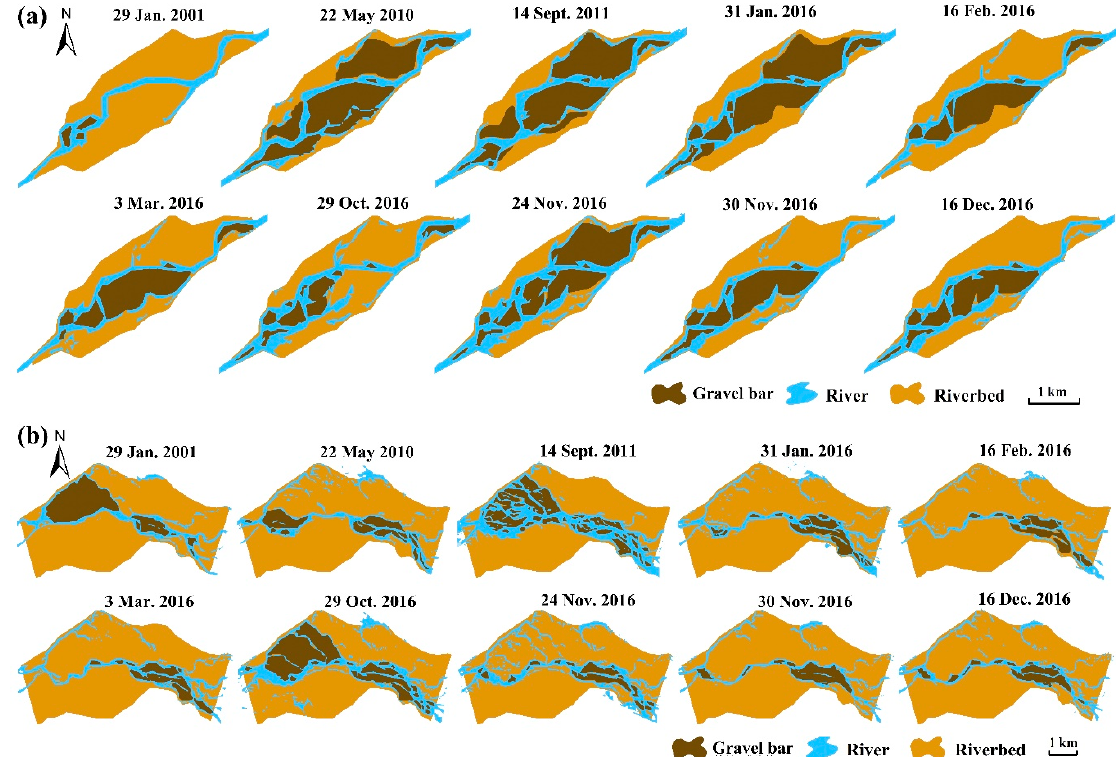
Figure 9. Morphological changes of local braided channel in RS1 and RS2 based on the remote sensing data. ( a ) RS1_B1; ( b ) RS2_B2.